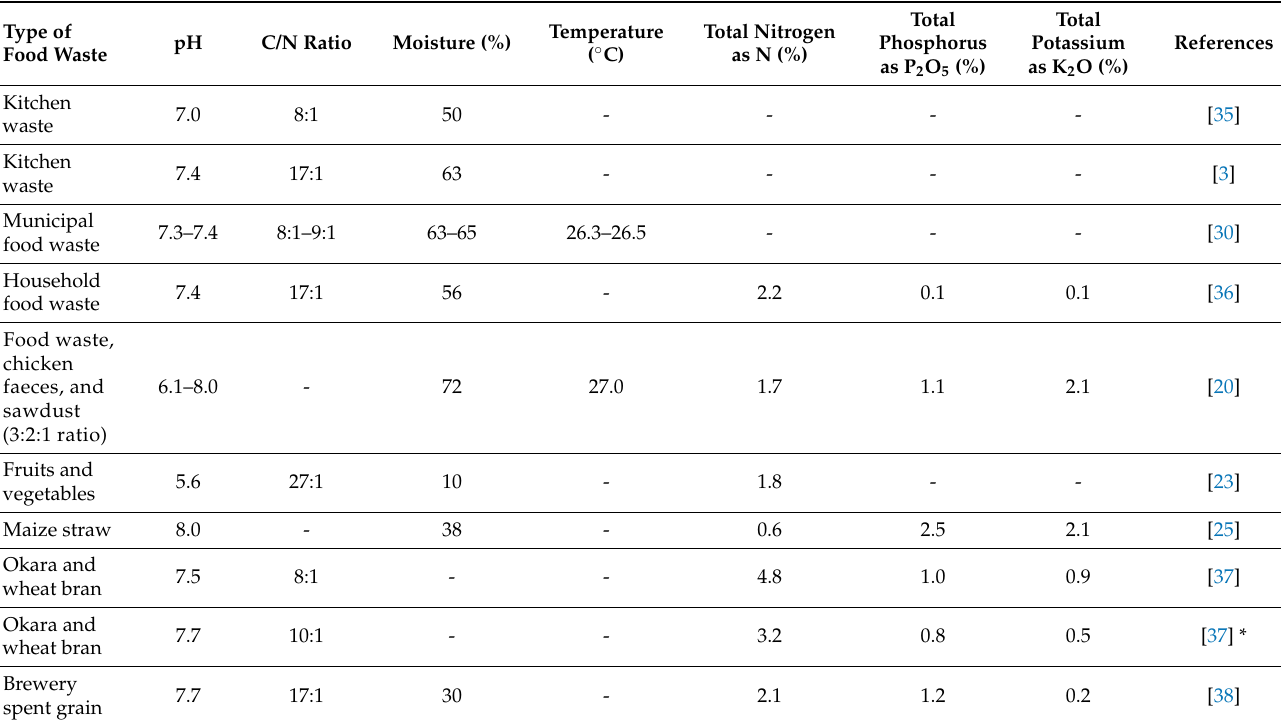
Table 1. The physiochemical characteristics of BSFL frass from different food waste